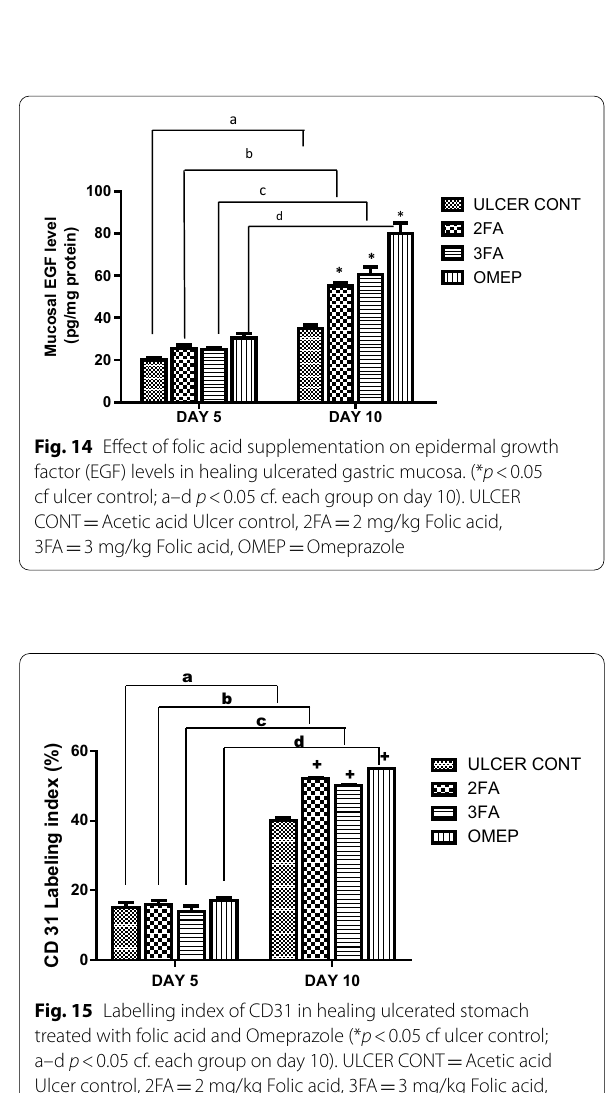
Fig. 15 Labelling index of CD31 in healing ulcerated stomach treated with folic acid and Omeprazole (* p < 0.05 cf ulcer control; a–d p < 0.05 cf. each group on day 10). ULCER CONT Acetic acid = Ulcer control, 2FA 2 mg/kg Folic acid, 3FA 3 mg/kg Folic acid, = = OMEP